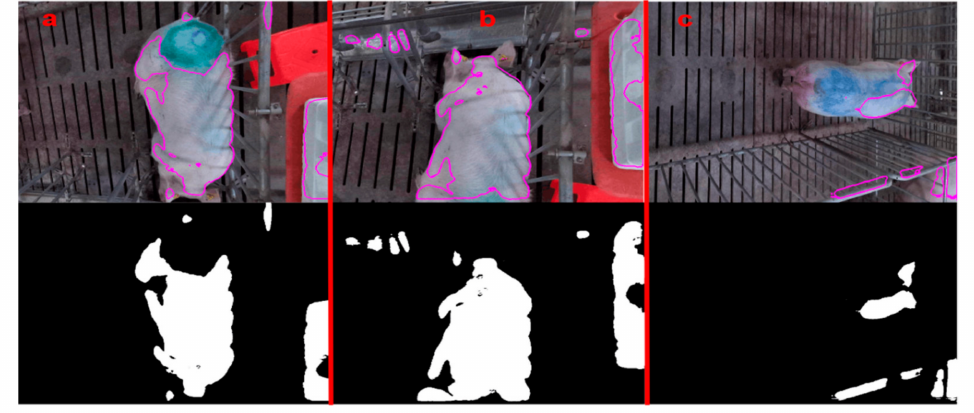
Figure 11. Performance effect of the UNet-Attention